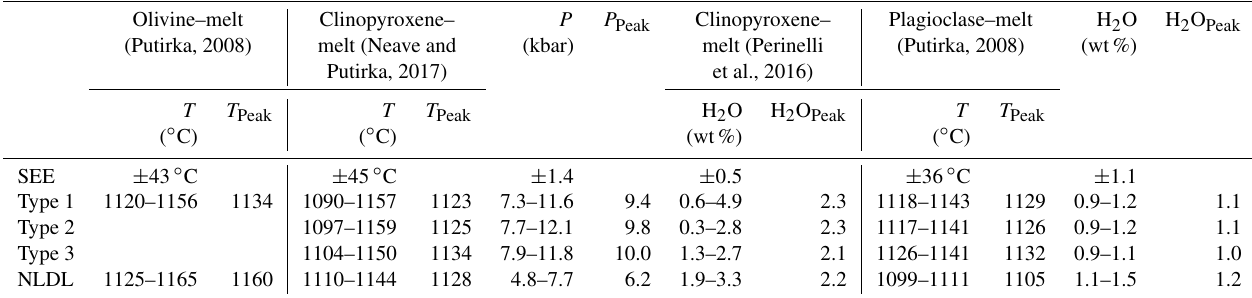
Table 3. Geothermobarometry and hygrometry estimations derived for samples from the WVF based on various olivine, clinopyroxene and plagioclase